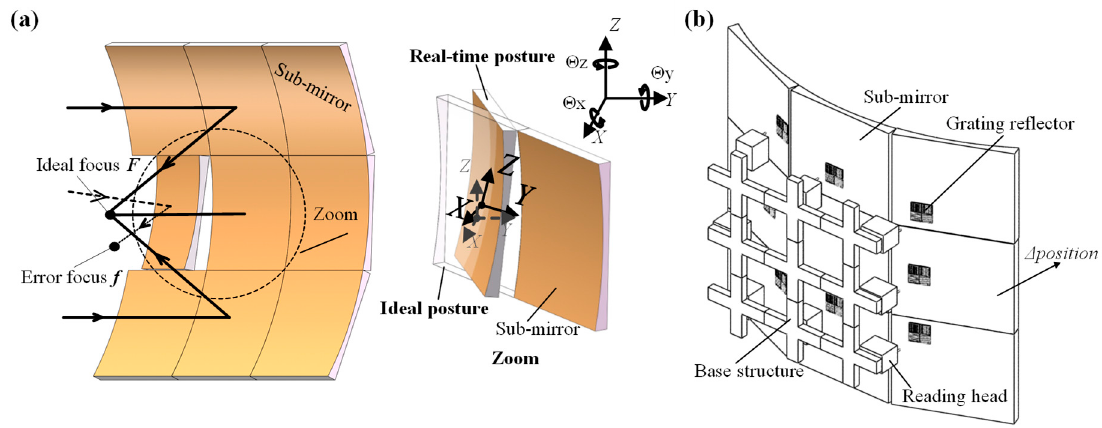
Figure 1. ( a ) The focus change of the synthetic aperture optics (SAO) and the ideal and real-time postures of the sub-mirror; ( b ) the application of the encoder.